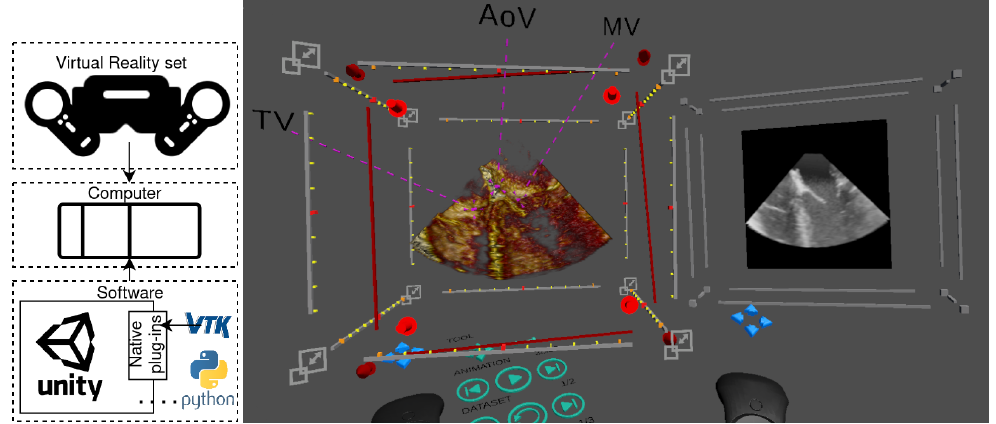
Figure 1. System overview ( left ) including the hardware (VR set and computer) and software (Unity application connected to Python and to VTK through Unity’s native plug-ins) and an example of a screen capture of our virtual reality application ( right ). This case shows a cut of a 3D ultrasound image of the left ventricle with three highlighted landmarks (TV—tricuspid valve, AoV—aortic valve, MV—mitral valve) and a multiplanar reconstruction plane showing the cropping